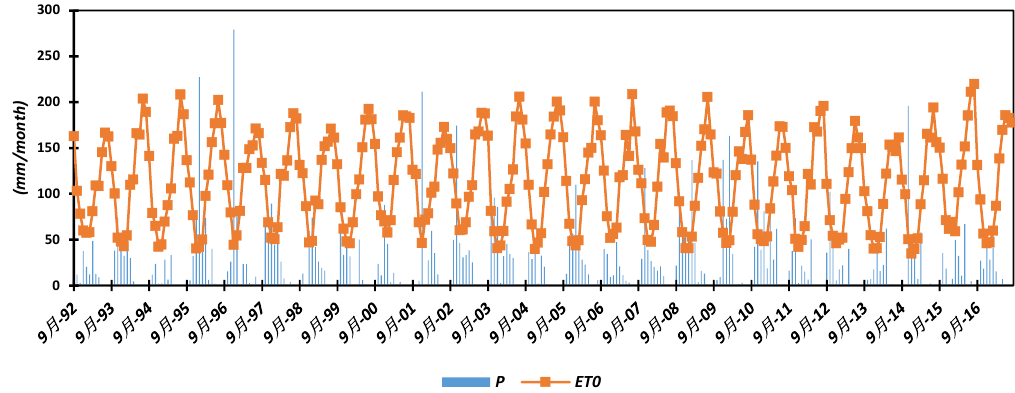
Figure 3. Doukkala irrigation scheme: Monthly reference evapotranspiration ET 0 and precipitation (P); 1992–2017.